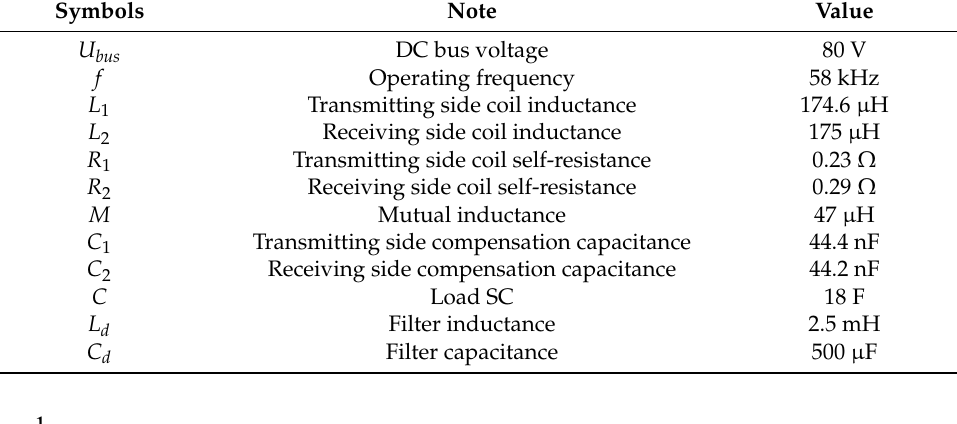
Table 1. Experiment platform parameters. Figure 6. Curve of the transfer efficiency vs. u SC .